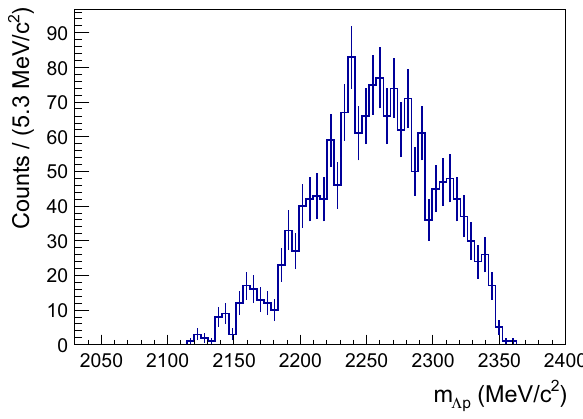
Fig. 8 The experimental (cid:2) p invariant mass spectrum obtained select- ing back-to-back (cid:2) p events (cos θ (cid:2) p < − 0 . 8), in analogy with the data analysis performed by FINUDA in Ref [33]